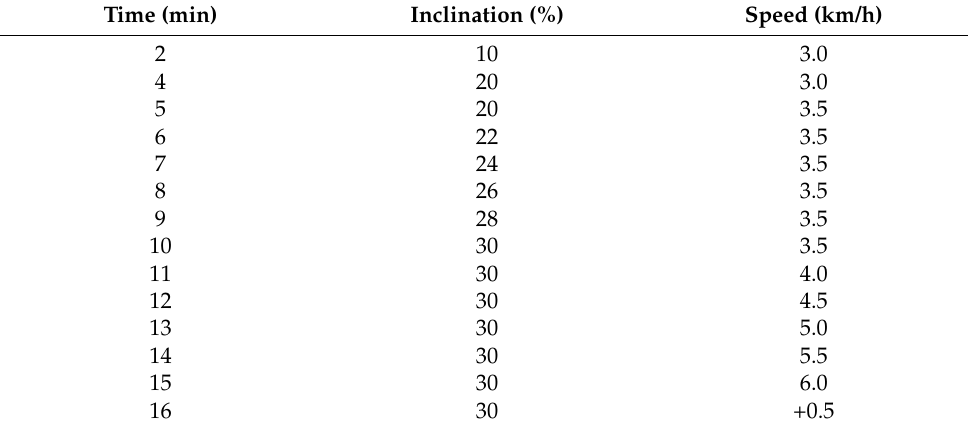
Table 3. Schematic of the SKIMO